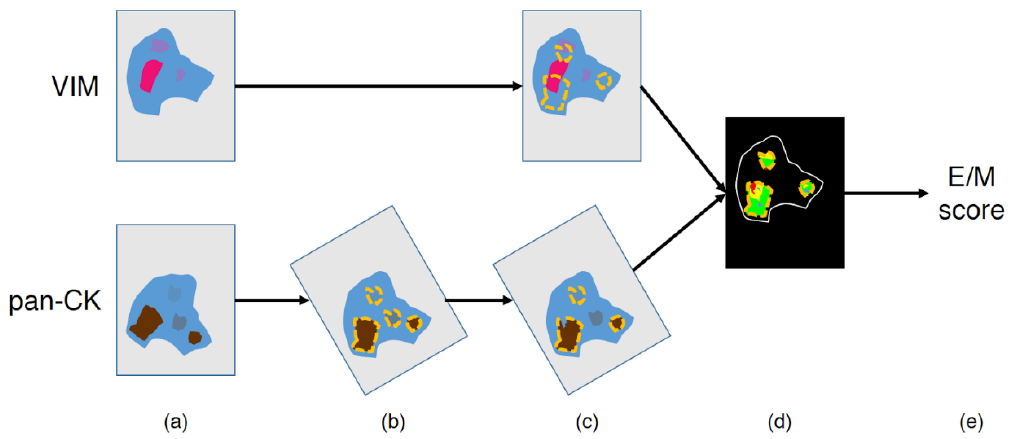
Figure 2. Image processing workflow to quantify the hybrid epithelial / mesenchymal (E / M) score. ( a ) Input images, ( b ) image registration and automatic annotation of the pan-CK-positive (pan-CK + ) regions at low (4 × ) magnification, ( c ) manual exclusion of irrelevant annotations (e.g., necrosis areas and / or tissue defects), ( d ) Vim-positive (VIM + ) and pan-CK + detection in the final annotations (cf. details in Figure 3), and ( e ) E / M score computation (cf. details in Figure 3).